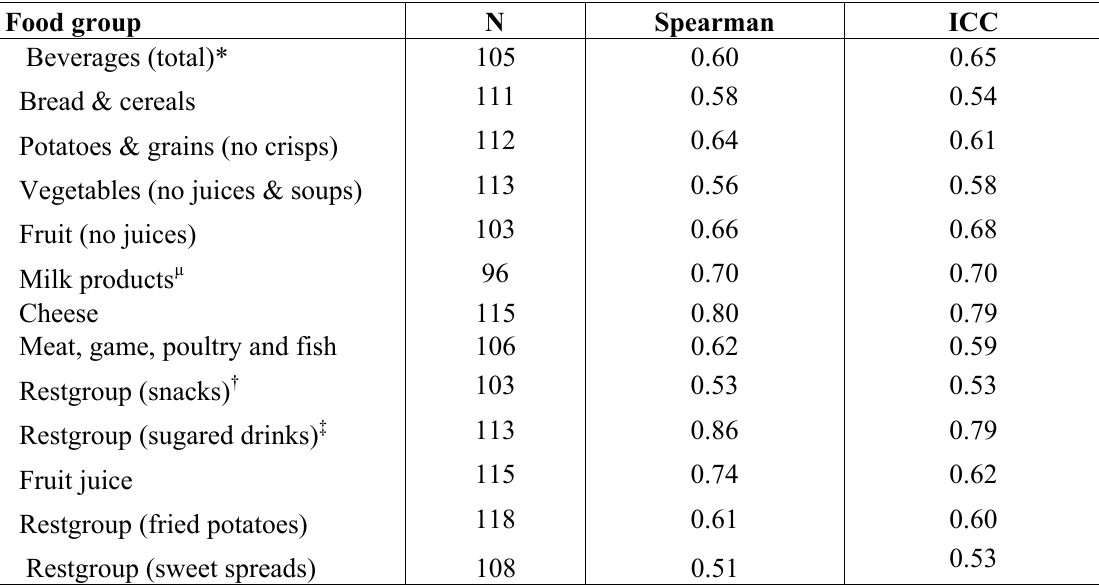
Table 3. Spearman correlations and intra-class correlations (ICC) between FFQ1 and FFQ2 for food(group)